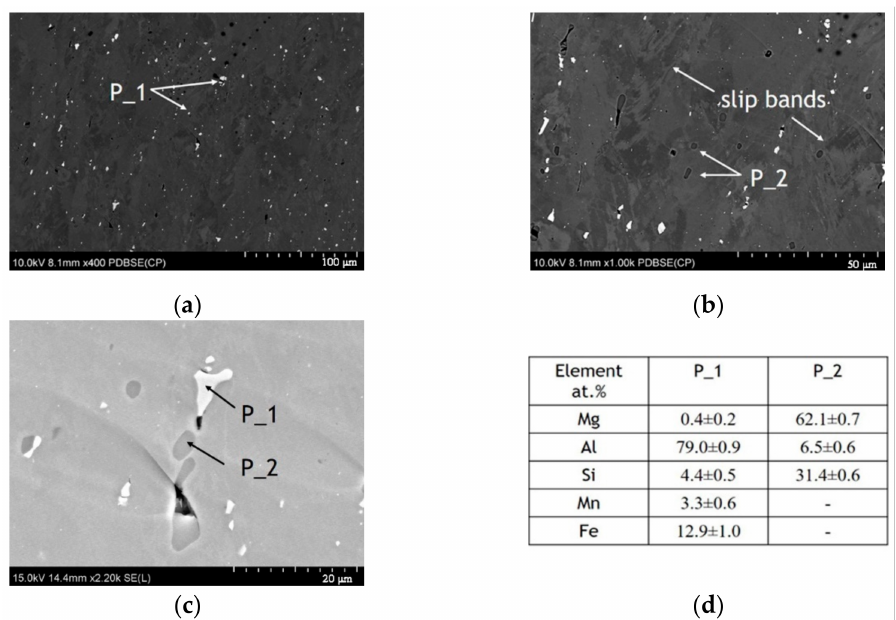
Figure 3. SEM images of the microstructure of the AA5457 sheet in the deformed area (B): ( a ) and ( b ), images showing the overall distribution of intermetallic particles, ( c ), image showing the morphology and area surrounding the intermetallic particles P_1 and P_2, and ( d ), the chemical analysis of the intermetallic particles P_1 and P_2 marked in panel c.